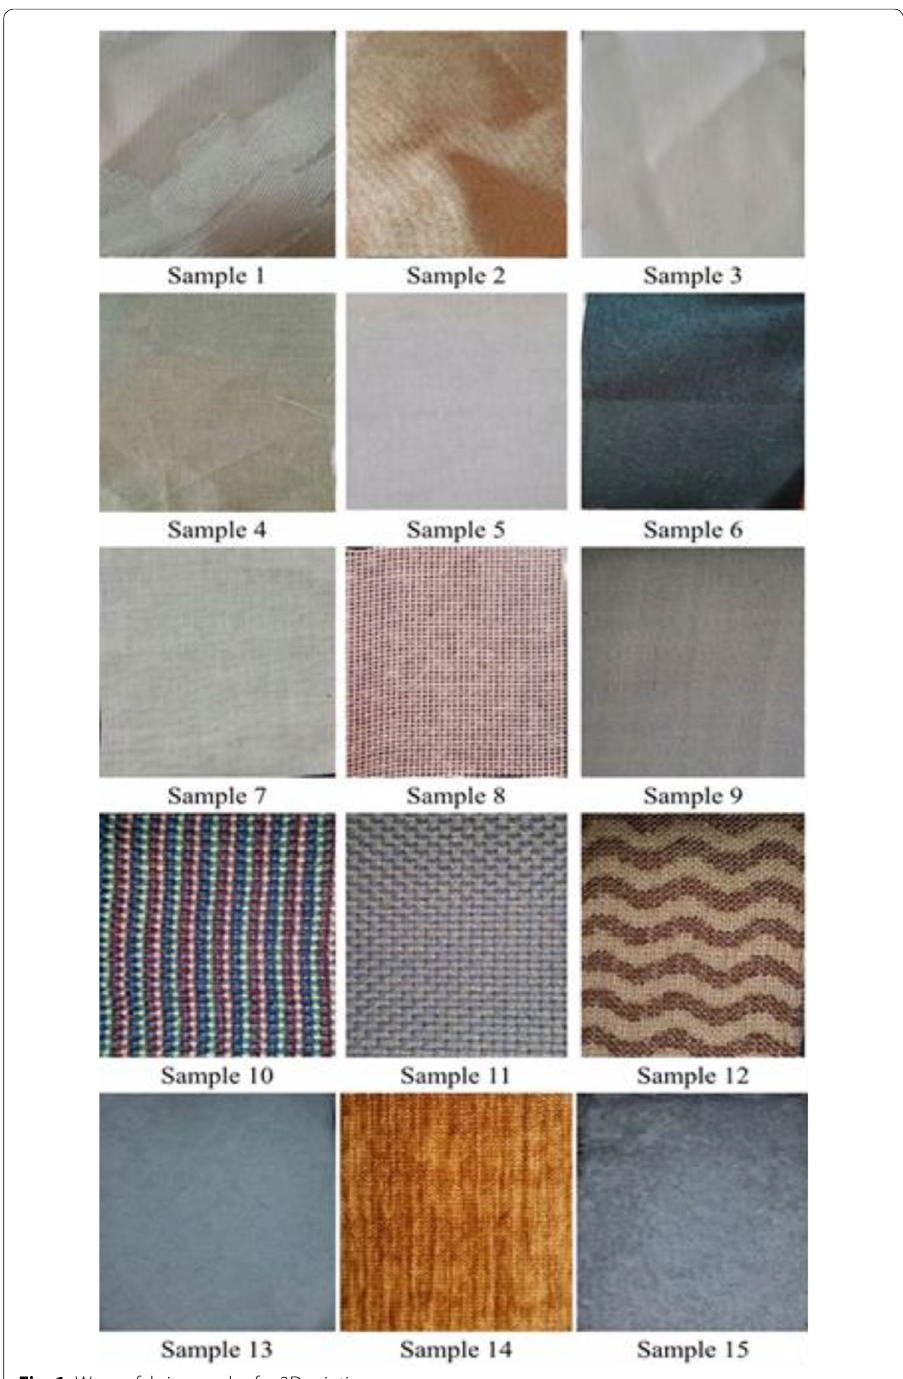
Fig. 1 Woven fabric samples for 3D